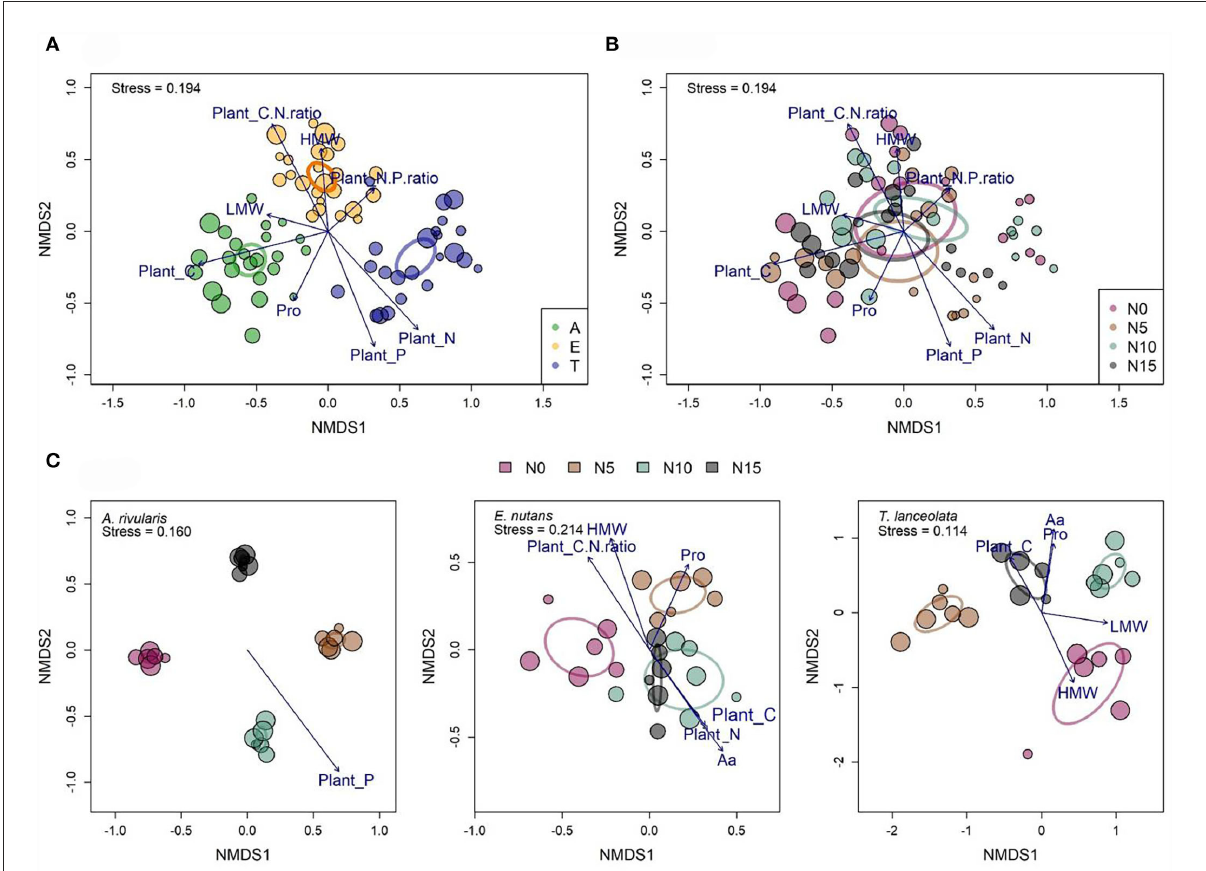
FIGURE4 Community structure of fungal endophytes among different hosts (A) , N gradients (B) , and within each host along the N gradients (C) were assessed with non-metric multidimensional scaling (NMDS) (Bray–Curtis distance). Dot size is proportional to the operational taxonomic unit (OTU) richness of individual samples ( n = 71). Ellipses with different colors indicate 95% confidence intervals. Significant plant variables that are correlated with each community ordination are shown. Pro: soluble proteins. LMW, low-molecular weight carbohydrates; HMW, high-molecular weight carbohydrates; Aa, total free amino acids; A, Anemone rivularis ; E, Elymus nutans ; T, Thermopsis lanceolata . N0, N5, N10, and N15 referring to 0, 5, 10, and 15g N (NH 4 NO 3 ) m − 2 yr − 1 treatments,